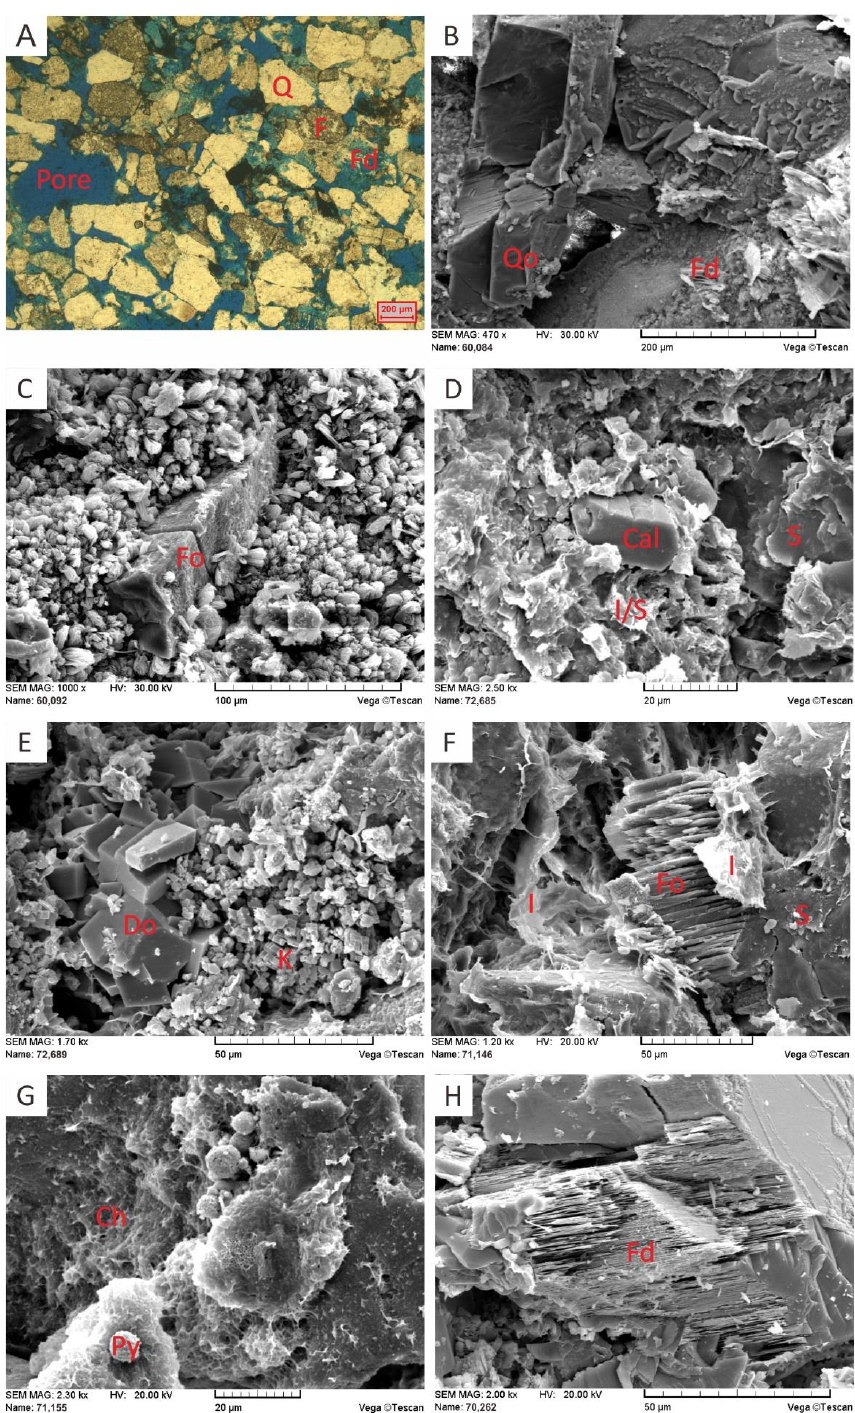
Figure 9. Plane polarized image and scanning electron microscope images showing diagenesis in sandstones. ( A ) Np1-5, depth: 2717.56 m, quartz, feldspar, kaolinite, pores, and feldspar dissolu- tions; ( B ) Np1-4, depth: 2438.26 m, quartz overgrowth, feldspar overgrowth, feldspar dissolution; ( C ) Np1-4, depth: 2510.85 m, feldspar overgrowth; ( D ) Np1-37, depth: 3173.50 m, calcite, illite, and I/S- mixed layer; ( E ) Np1-37, depth: 3174.29 m, Kaolinite, and dolomite; ( F ) Np101 × 8, depth: 2303.99 m, feldspar overgrowth, smectite, and illite; ( G ) Np103 × 2, depth: 1859.65 m, pyrite, and chlorite; ( H ) Np105, depth: 2839.94 m, feldspar dissolution. (Q—quartz, F—Feldspar, Fd—feldspar dissolution, Cal—calcite, Do—dolomite, K—kaolinite, S—smectite, I—illite, Ch—chlorite, I/S—illite/smectite- mixed layer, Py—pyrite, Qo—quartz overgrowth, Fo—feldspar